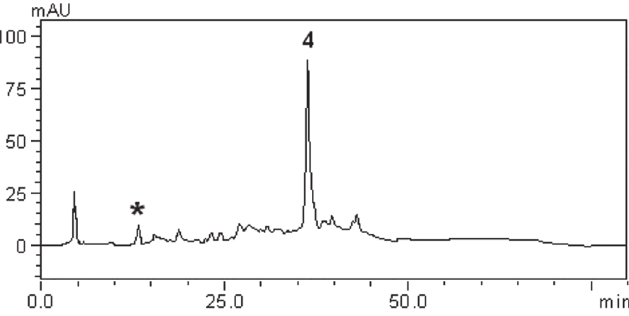
Figure 4 - HPLC analysis of rutin (4) of the n-BuOH fraction of the fruits, (*) unknown peak.